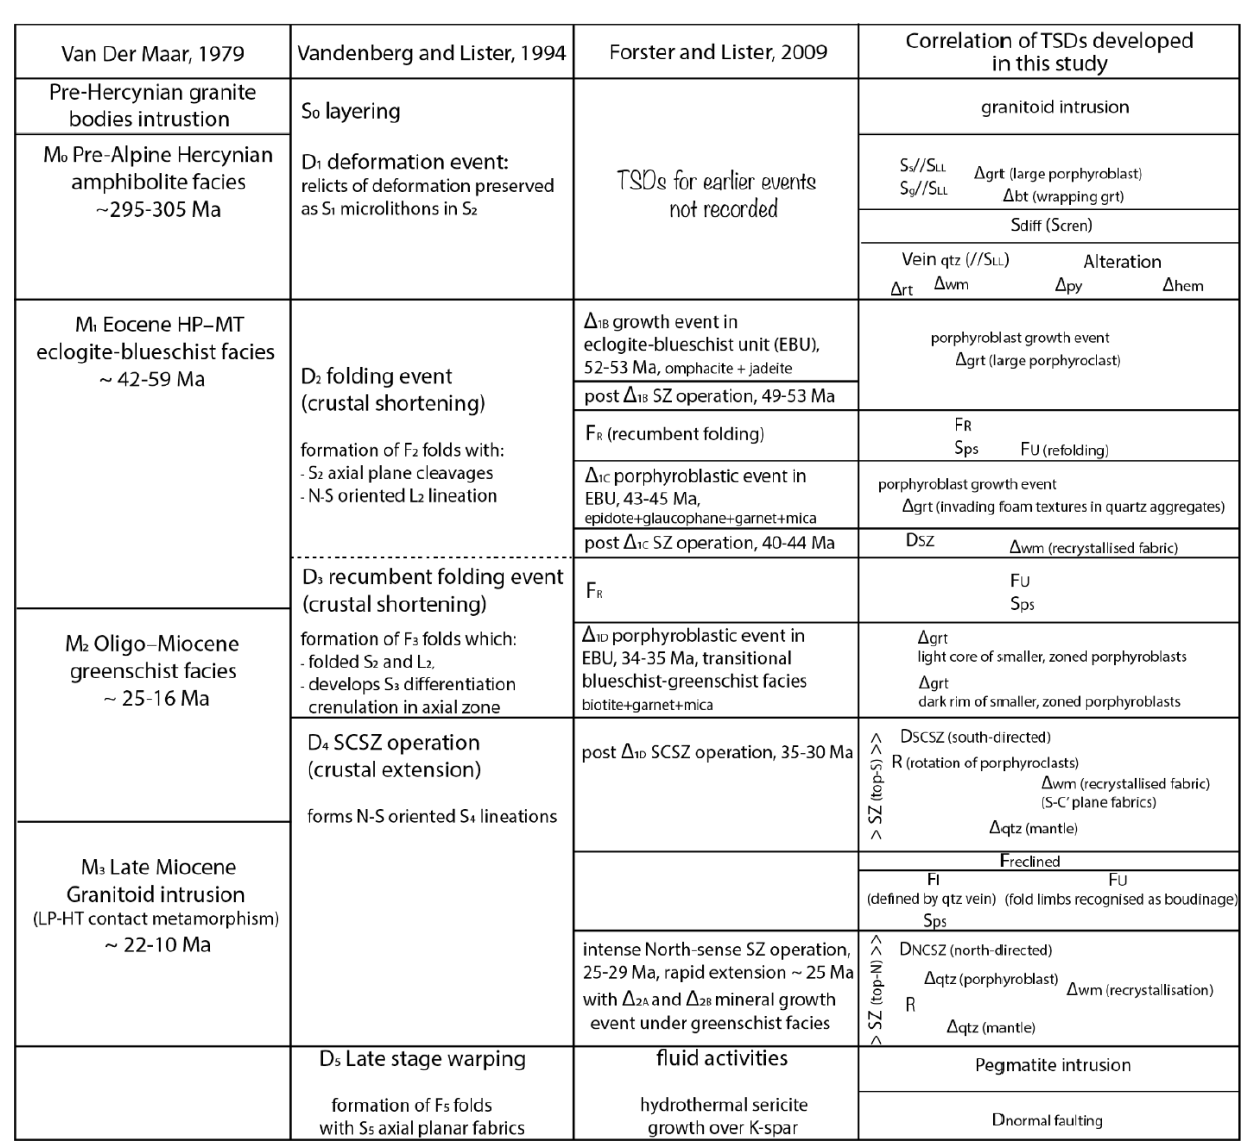
Table 1. Correlations between the results of previous work and the tectonic sequence diagrams (TSDs) developed in this paper. The results imply that parts of the garnet–mica schist have been shared some parts of history of high-pressure/low-temperature metamorphism as occurred in the lowermost schist units of the Cycladic Blueschist